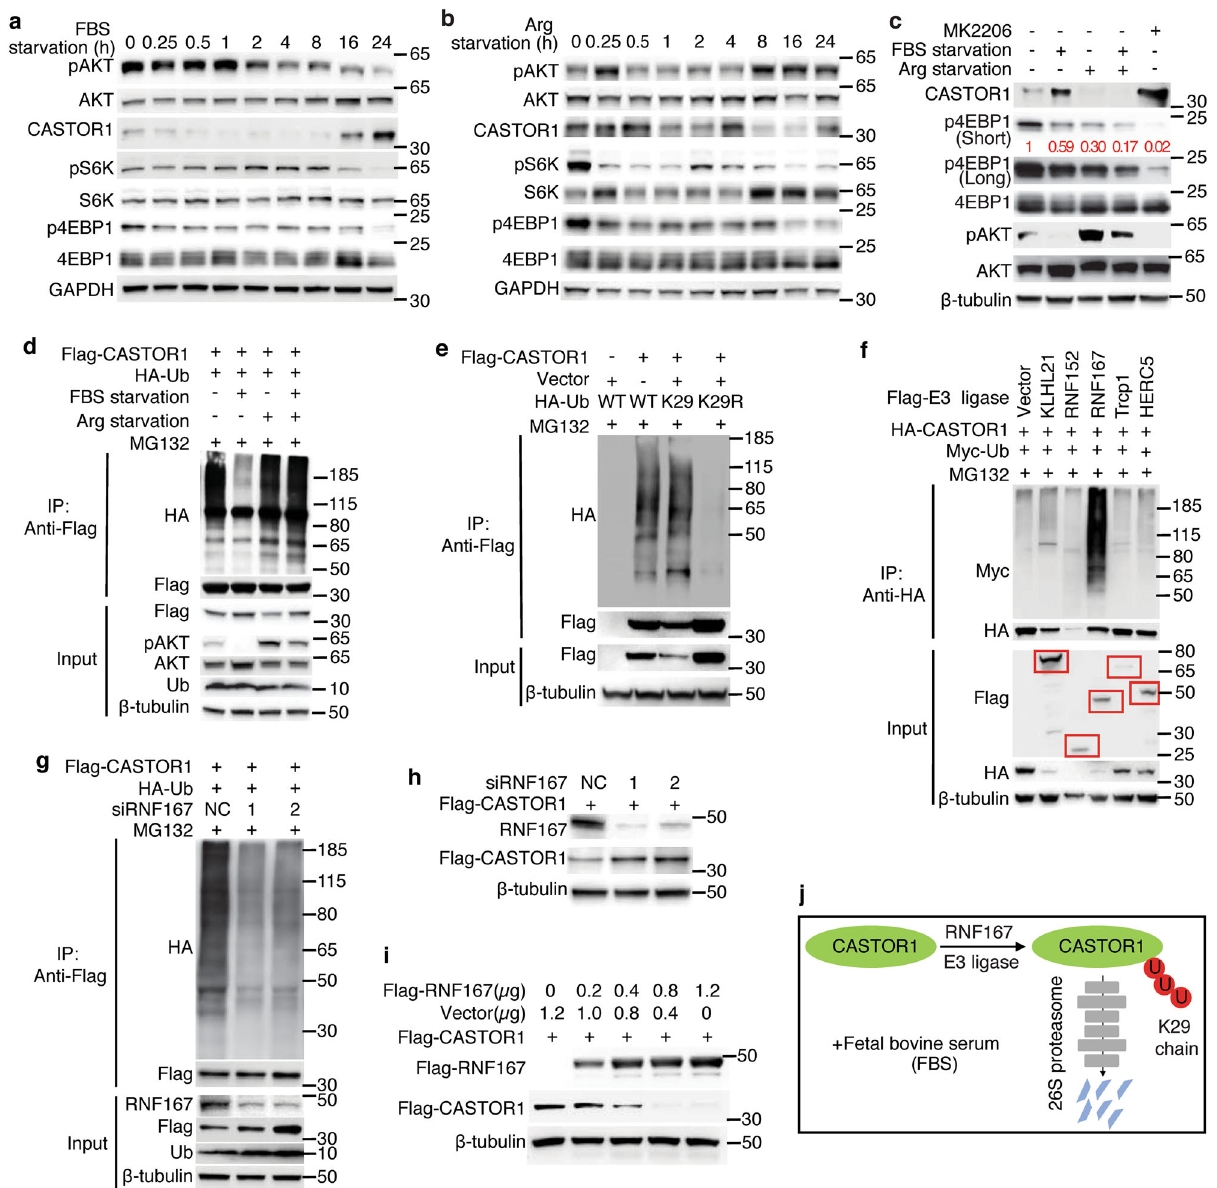
Fig. 1 RNF167 mediates K29-linked polyubiquitination and degradation of CASTOR1 in response to growth factors. a Kinetics of CASTOR1 protein level and activation status of AKT and mTORC1 following fetal bovine serum (FBS) deprivation in 293T cells. b Kinetics of CASTOR1 protein level